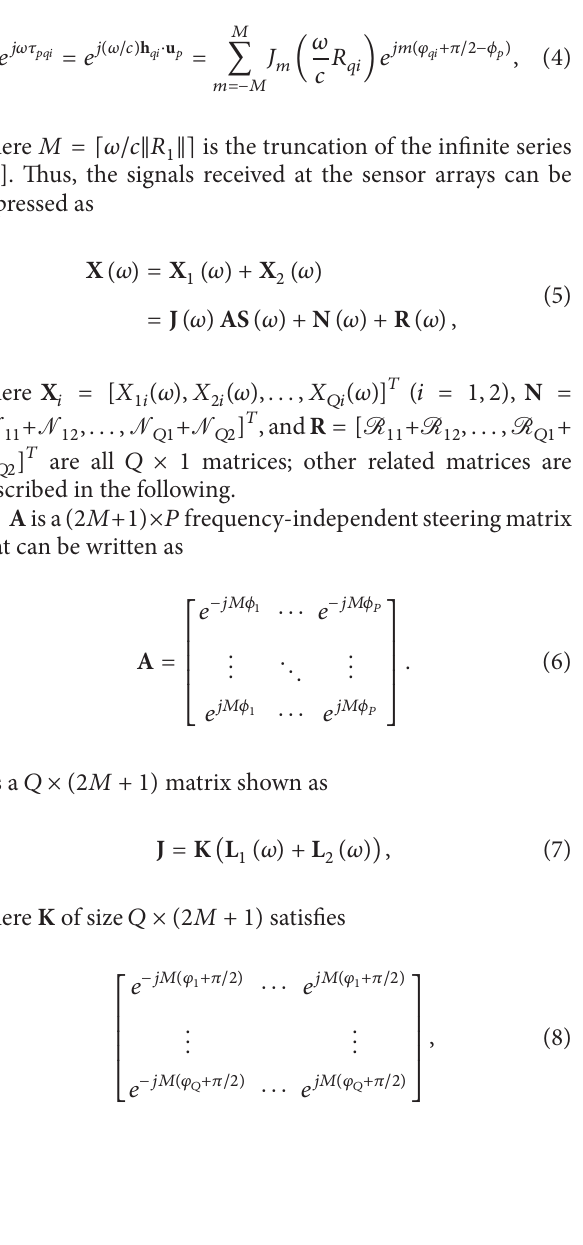
𝑞 = 1, . . . , 𝑄 and 𝑖 = 1, 2 in the polar coordinates